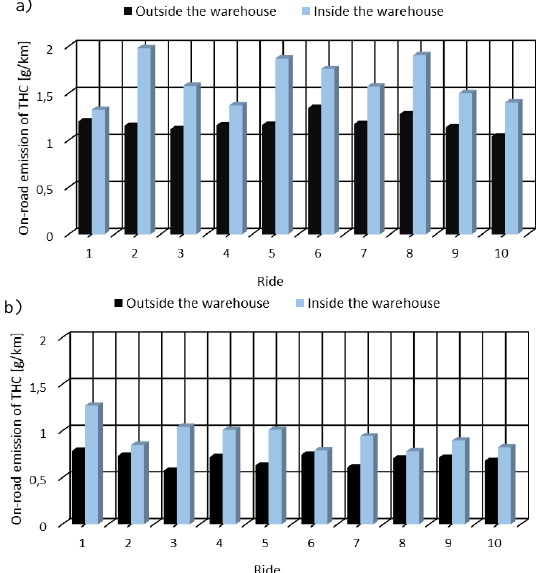
Fig. 8. On-road emissions of THC of a forklift truck equipped with a CI engine: a) when carrying a load, b) when driving unloaded